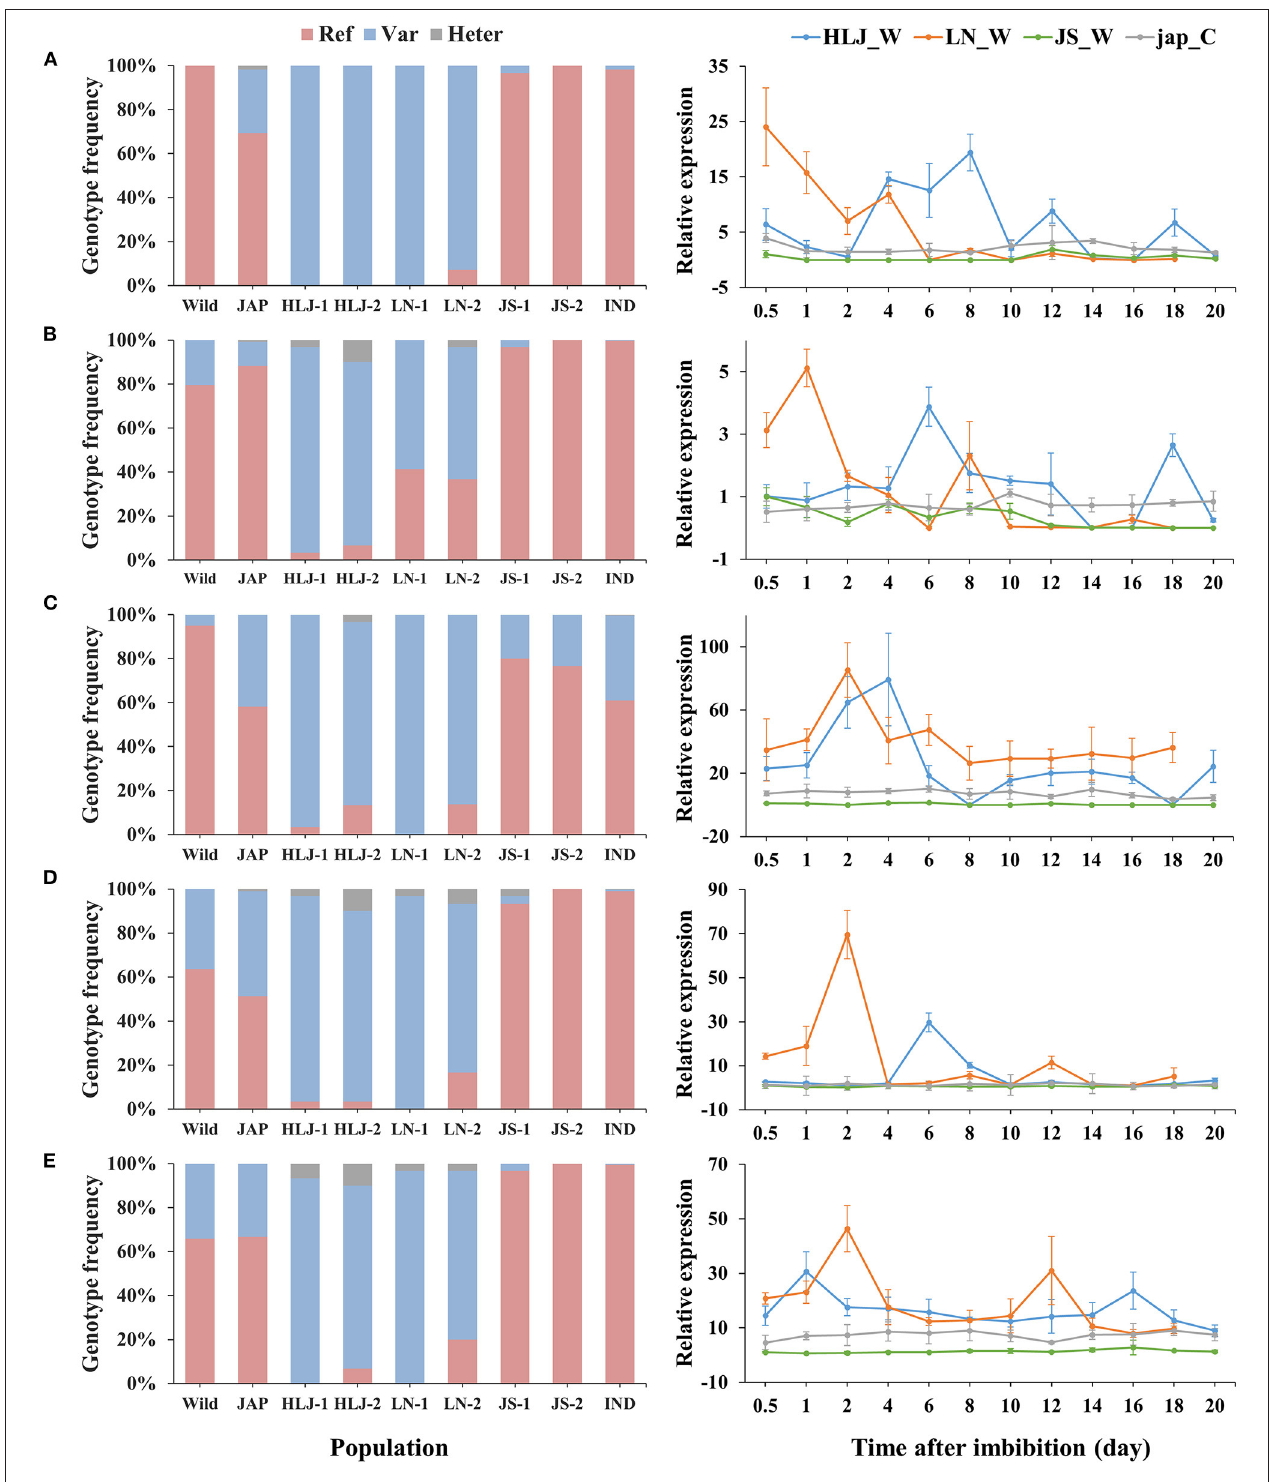
FIGURE 4 | Genotype frequencies (left) and expression patterns (right) of 5 genes containing potential adaptive SNPs. (A–E) represent Os03g0122600 , Os10g0136150 , Os10g0155800 , Os11g0191300 , Os08g0227200 , respectively. Ref, the homozygote of the reference base; Var, the homozygote of the variant base; Heter, the heterozygote of the reference and variant bases. HLJ_W, weedy rice from HLJ province; LN_W, weedy rice from LN province; JS_W, weedy rice from JS province; jap_C, the co-existing japonica rice.